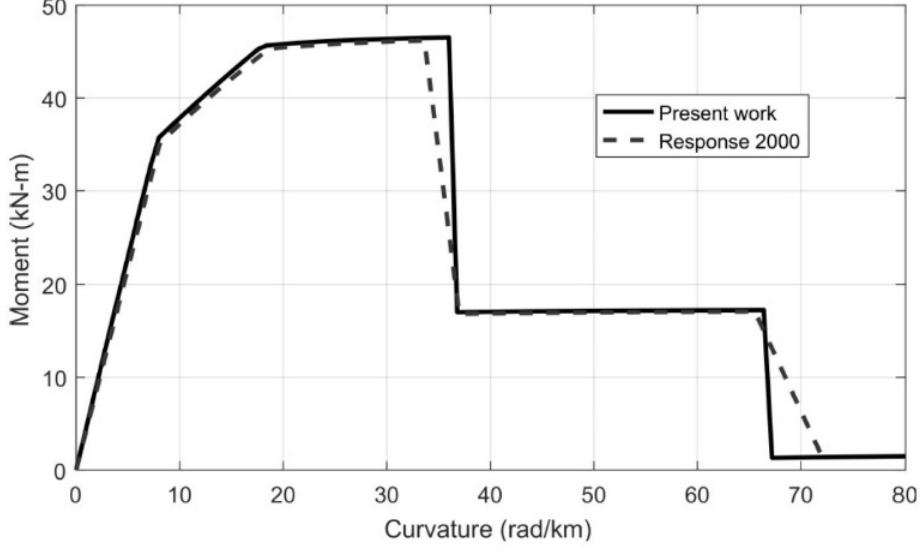
Figure 12. Moment-rotation diagram for the ellipsoidal cross